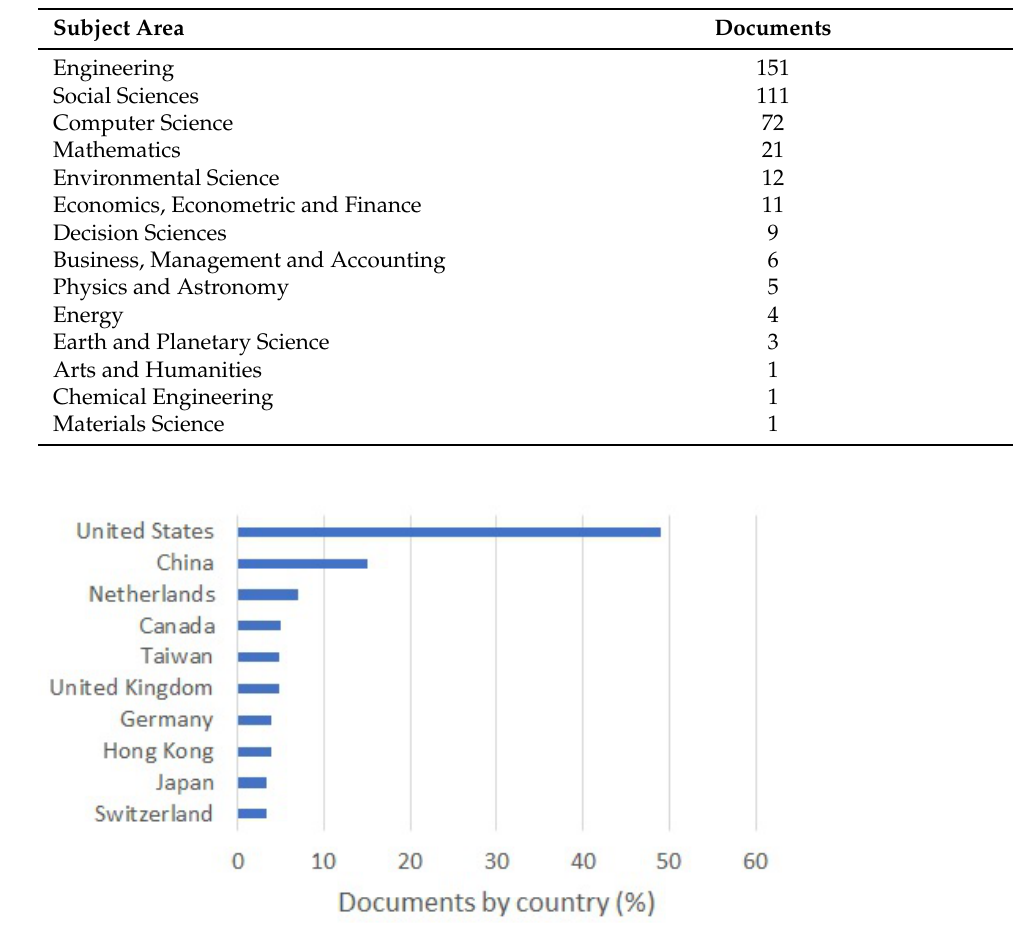
Table 2. Analysis of the search results in terms of subject areas, from Scopus.